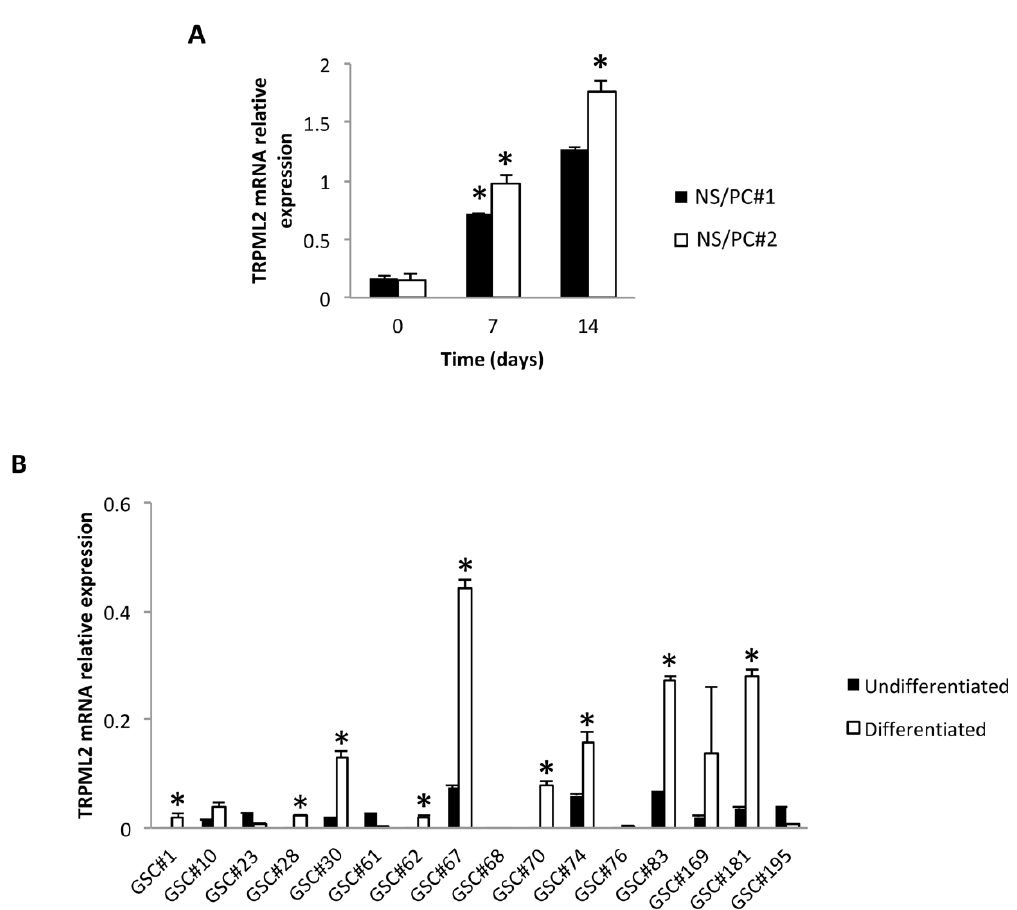
Figure 1. TRPML2 mRNA expression in neural stem/progenitor cells and glioma stem-like cells. ( A ) The relative TRPML2 mRNA expression in human neural stem/progenitor (NS/PC#1 and NS/PC#2) cells was evaluated by qRT-PCR during the differentiation. TRPML2 mRNA levels were normalized for GAPDH expression. Data are expressed as mean ± SD. * p < 0.01 vs. time 0. ( B ) The relative TRPML2 mRNA expression was evaluated by qRT-PCR in undifferentiated GSC lines and after 14 differentiation days. TRPML2 mRNA levels were normalized for GAPDH expression. Data are expressed as mean ± SD. * p < 0.05 vs. undifferentiated cells.